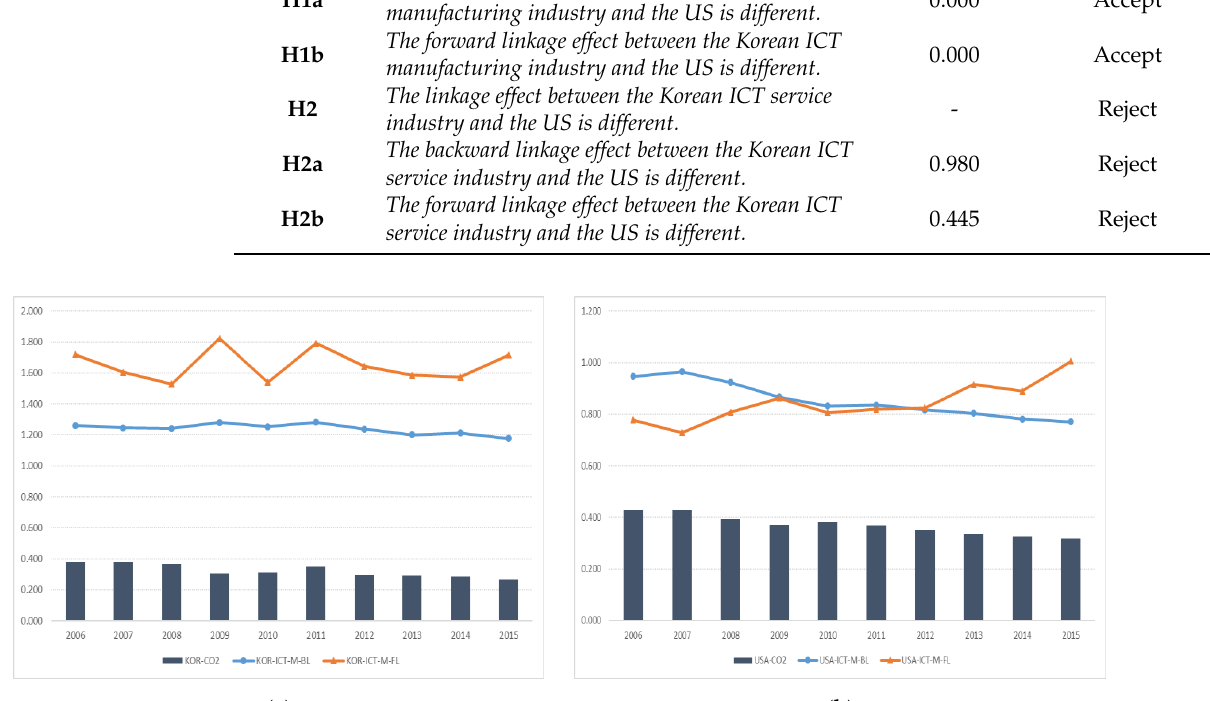
Figure 1. Trends of linkage effect and CO₂ emission of ICT manufacturing between Korea and USA: ( a ) Korea (2006–2015); ( b ) USA (2006–2015). Source: authors’ own computations on the data collected from OECD stat [45].